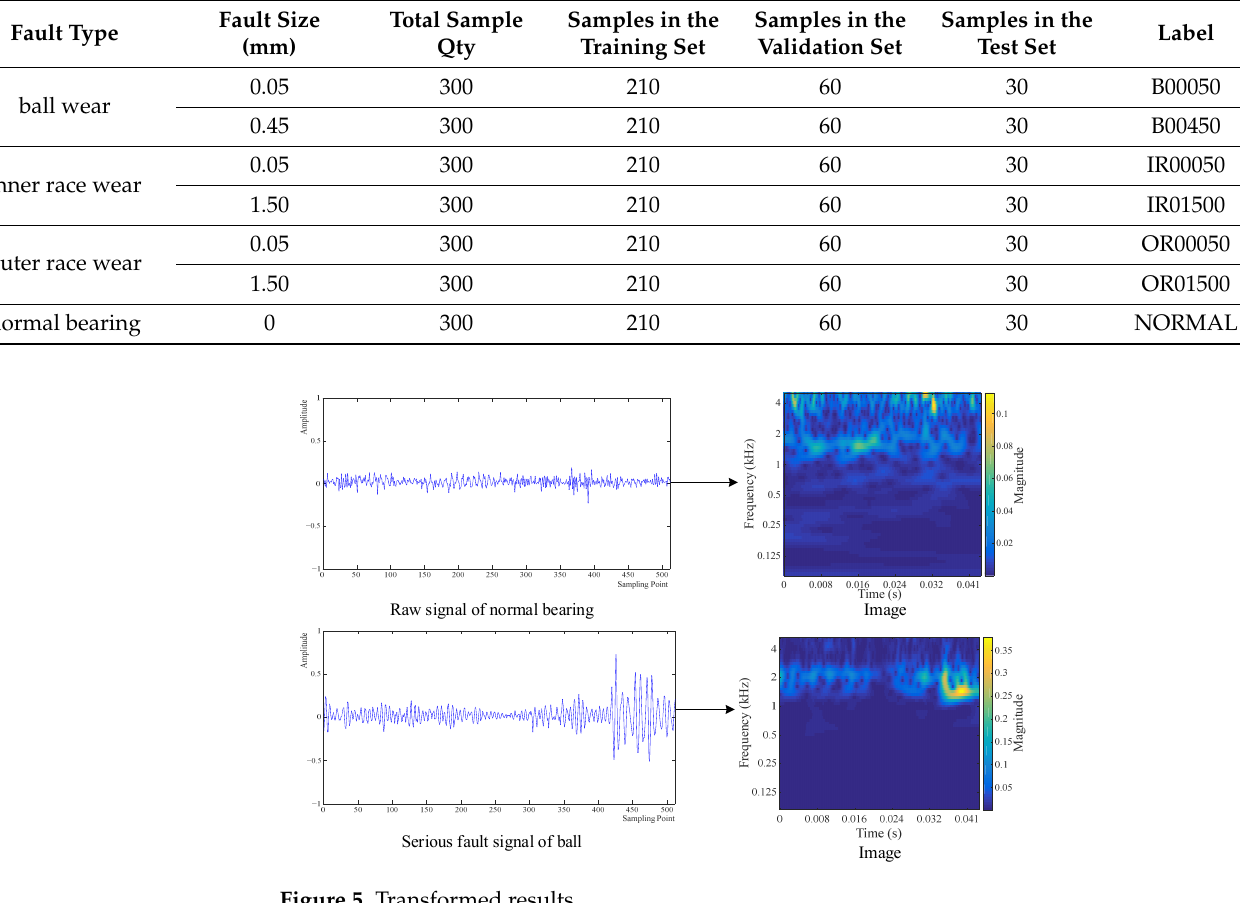
Figure 6. Experimental results for all models: ( a ) training set loss; ( b ) validation set accuracy. The trained models were used for intelligent classification of the test set. All models were trained ten times to prevent random uncertainty in models, and the average of the ten tests was used as the final diagnostic result. The results are shown in Table 5; the ResNet34 ‐ TL model has the highest test accuracy of 96.29%. In this section, the Res ‐ Net34 ‐ TL model is sufficient to solve the accurate diagnosis of rolling bearing faults with fewer samples during network training and with only 20 iterations, which has applica ‐ tion value for sizeable rotating machinery production work. It is also evident from the training time that the proposed network structure can substantially improve the recog ‐ nition rate of fault types without affecting the speed of the actual network operation. In addition, the ResNet34 ‐ TL model has the lowest false alarm rate and missed alarm rate,